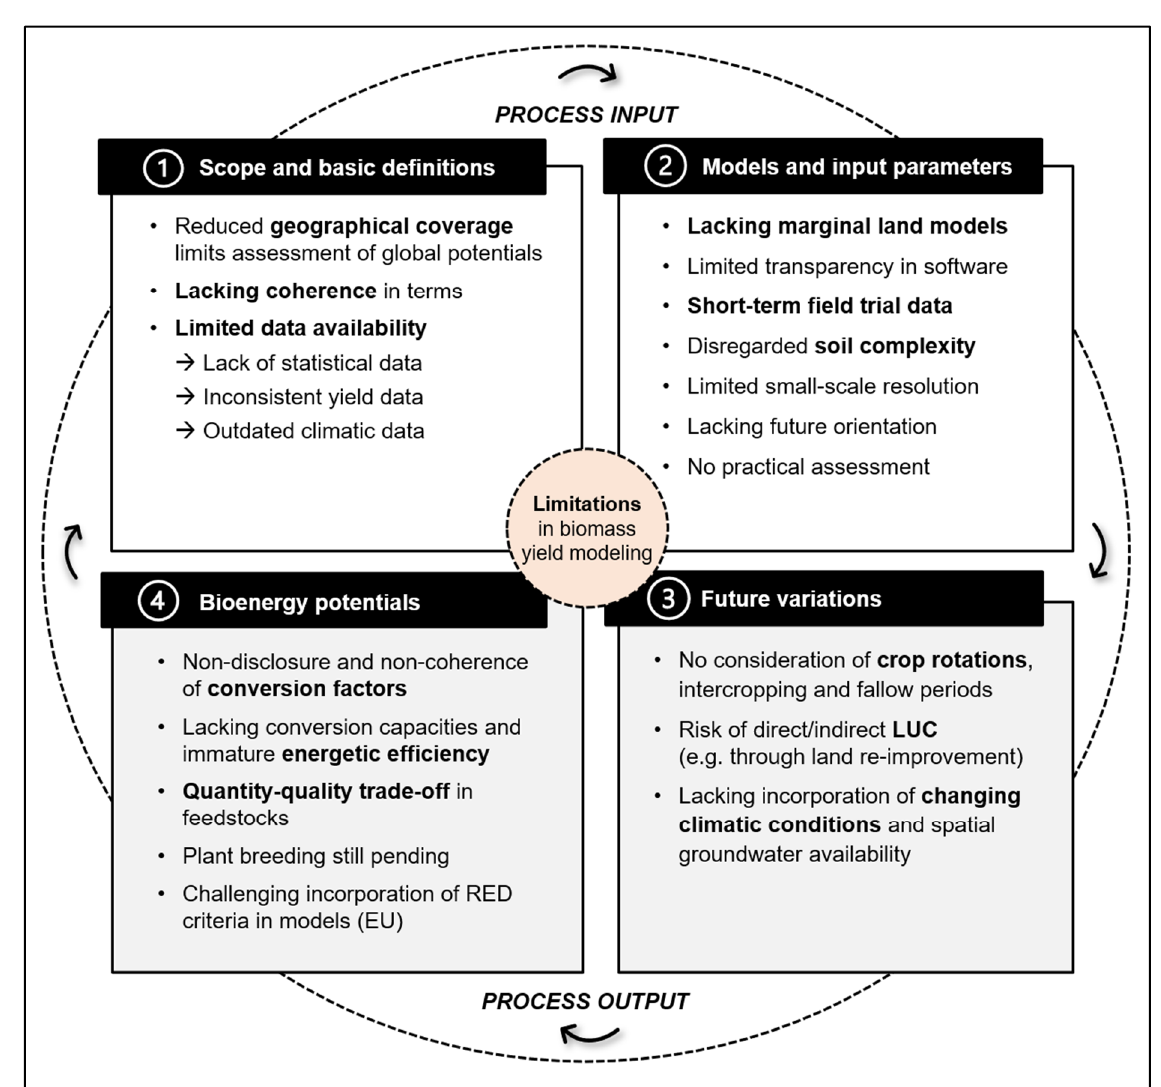
Figure 2. Overview on the most relevant limitations on input and output side of the modeling cycle (RED = Renewable Energy Directive, LUC = land use change).